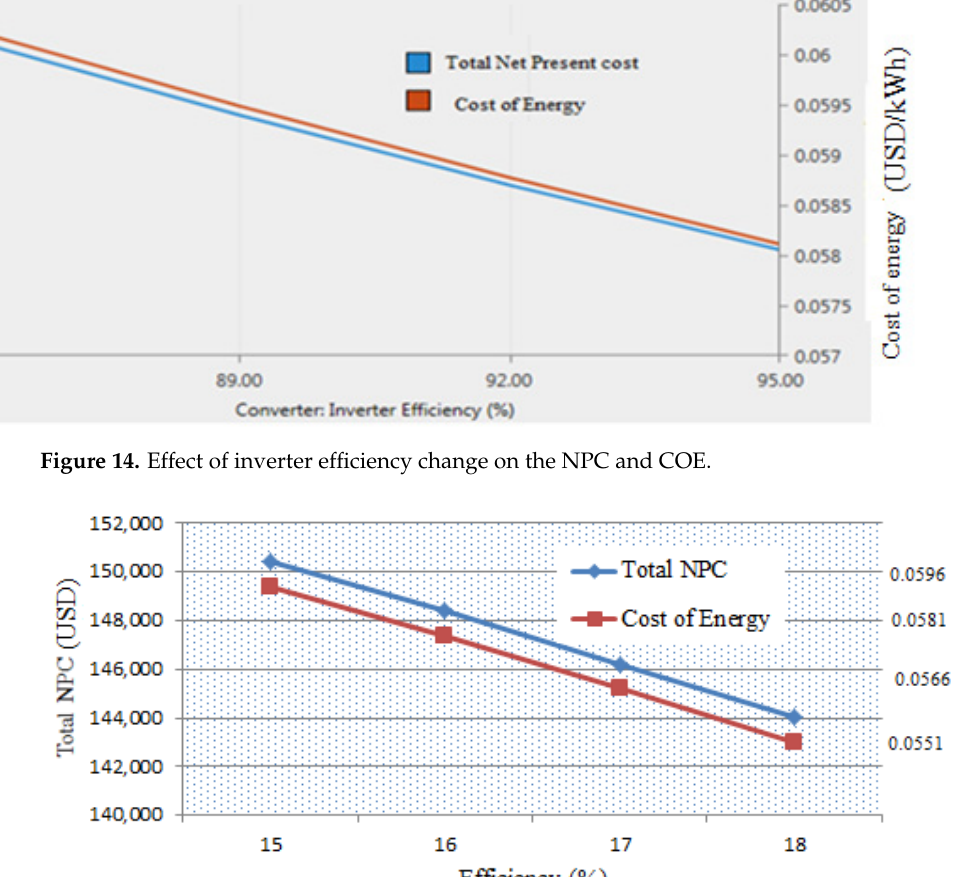
Figure 13. Impact of PV capital cost change on the NPC and COE.